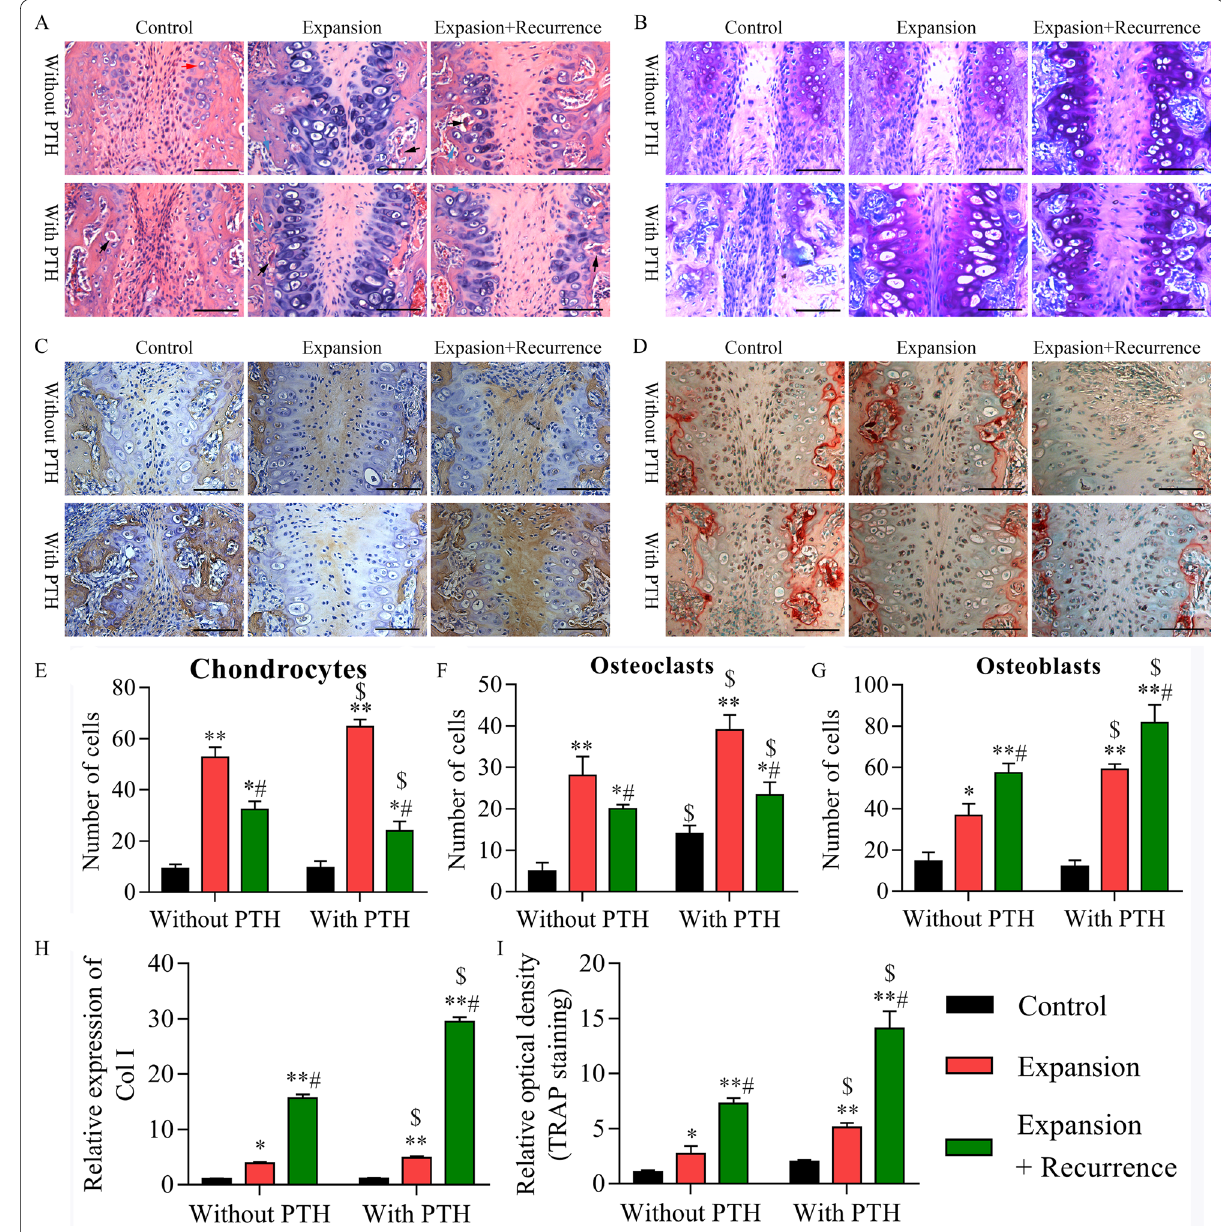
Fig. 4 PTH promoted bone remodeling and reduced relapse in the process of maxillary expansion. The rats were divided into control, PTH, expansion, expansion PTH, expansion relapse and expansion relapse PTH groups, respectively. A H&E staining was performed to evaluate + + + + the conditions of palatal suture tissue remodeling and widening. Magnification, 400 . B Toluidine blue staining was utilized to assess the changes × of chondrocytes in each group. Magnification, 400 . C IHC assay was used to detect the new bone formation in each group. Magnification, 400 . × × D TRAP staining was used to assess the osteoclasts and bone resorption in each group. Magnification, 400 . The white arrow indicates osteoclast × ,and the blue arrow indicates regenerated new bone. Based on the H&E staining results, the quantitative analysis of E chondrocytes, F osteoclasts, G osteoblasts was calculated in control, PTH, expansion, expansion PTH, expansion relapse and expansion relapse PTH groups. H The + + + + expression of collagen type I was counted based on the IHC results. I The relative optical density was counted according to the TRAP staining results. * P < 0.05, ** P < 0.01 versus control group; # P < 0.05 versus expansion group; $ P < 0.05 versus without PTH group. The red arrow indicates chondrocyte, the black arrow indicates osteoclast, and the blue arrow indicates